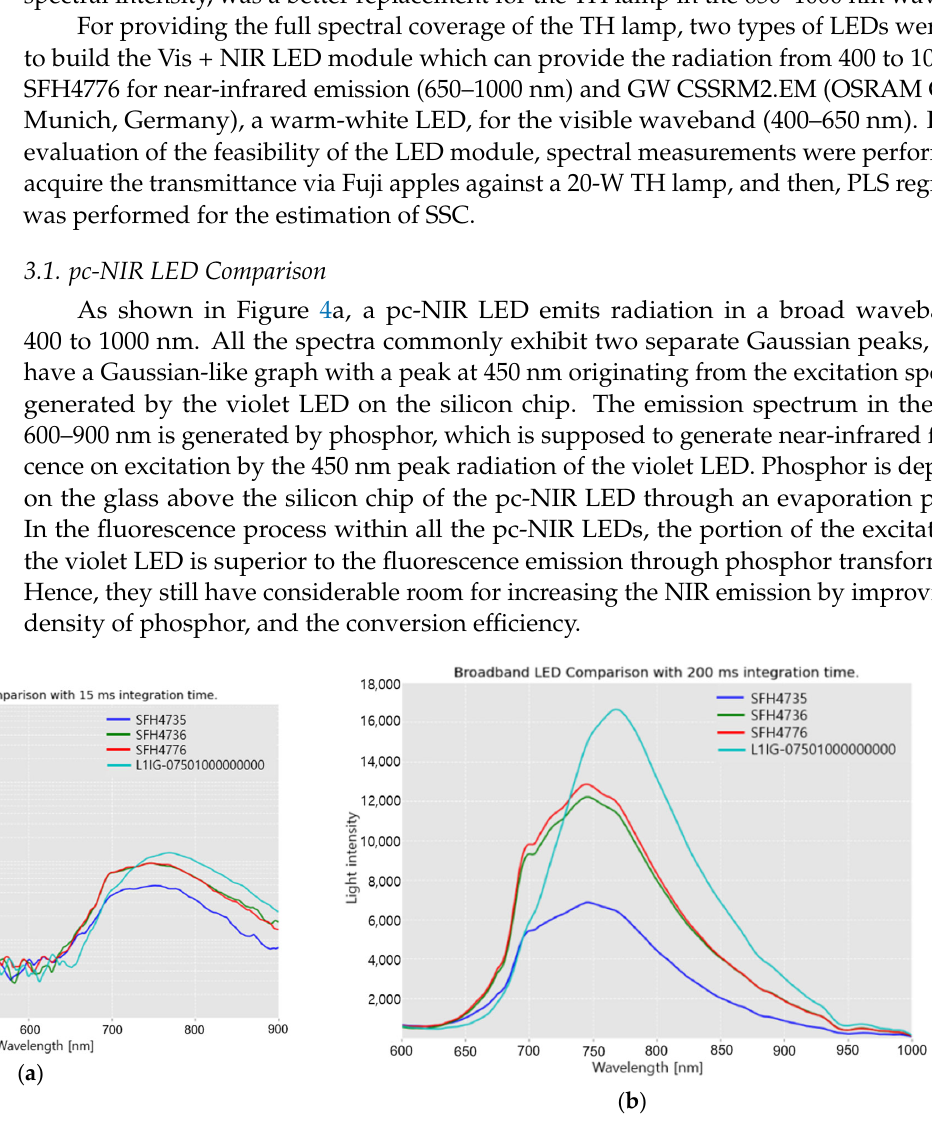
Figure 4. Spectral intensities of the radiation of pc-NIR LEDs (SFH4735, SFH4736, SFH4776, and L1IG-0750100000000): ( a ) Overall spectral intensity of radiation in the 400–900 nm range; ( b ) Enlarged image of the spectral intensity of radiation in the 600–1000 nm range.